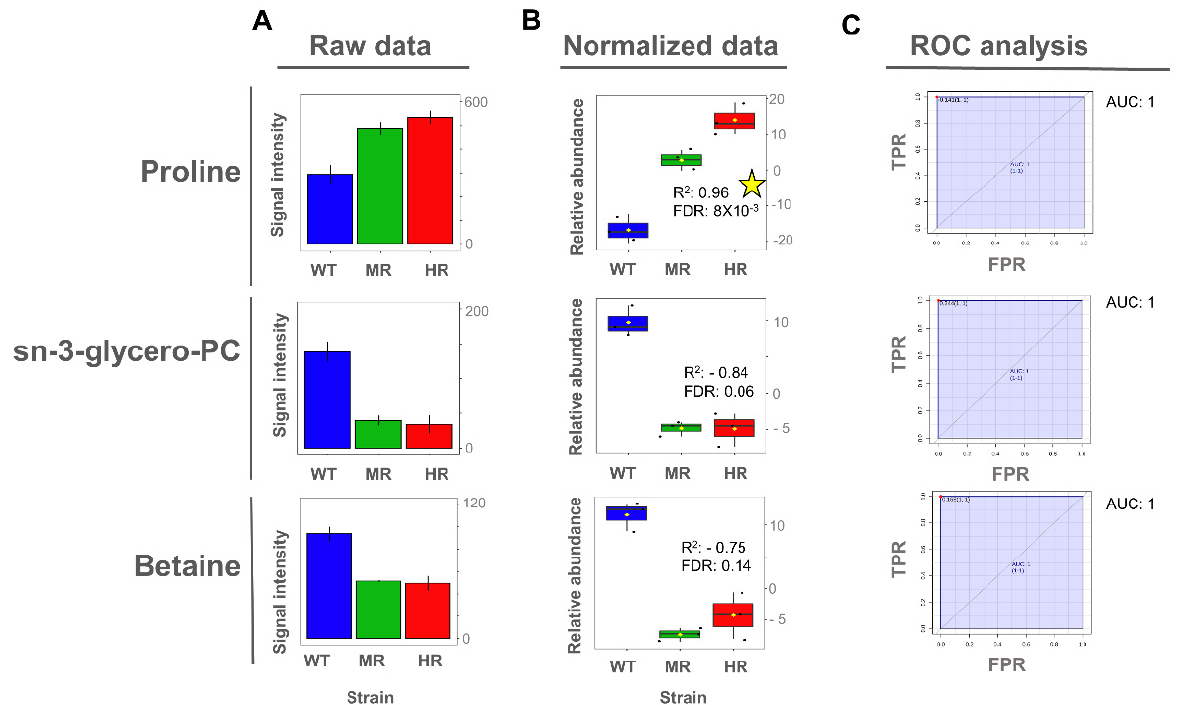
Figure 6. Proline, glycerol-phosphocholine, and betaine as potential biomarkers of antimony resistance at the intracellular level. ( A ) Bar plot of metabolite concentration as the raw intensity values. ( B ) Box plot of metabolite concentration as the normalized intensity values and showing the Pearson correlation scores. ( C ) Univariate ROC analysis comparing Sb III -resistant (MR and HR) vs. -sensitive strains (WT). Coefficient of determination by Pearson correlation (R 2 ). False discovery rate of the p -values obtained for the R 2 score (FDR). Significant high correlations (FDR ≤ 0.05) are highlighted with a yellow star. Sensitivity or true positive rate (TPR). Specificity or false positive rate (FPR). Area under the curve for univariate ROC analysis (AUC).